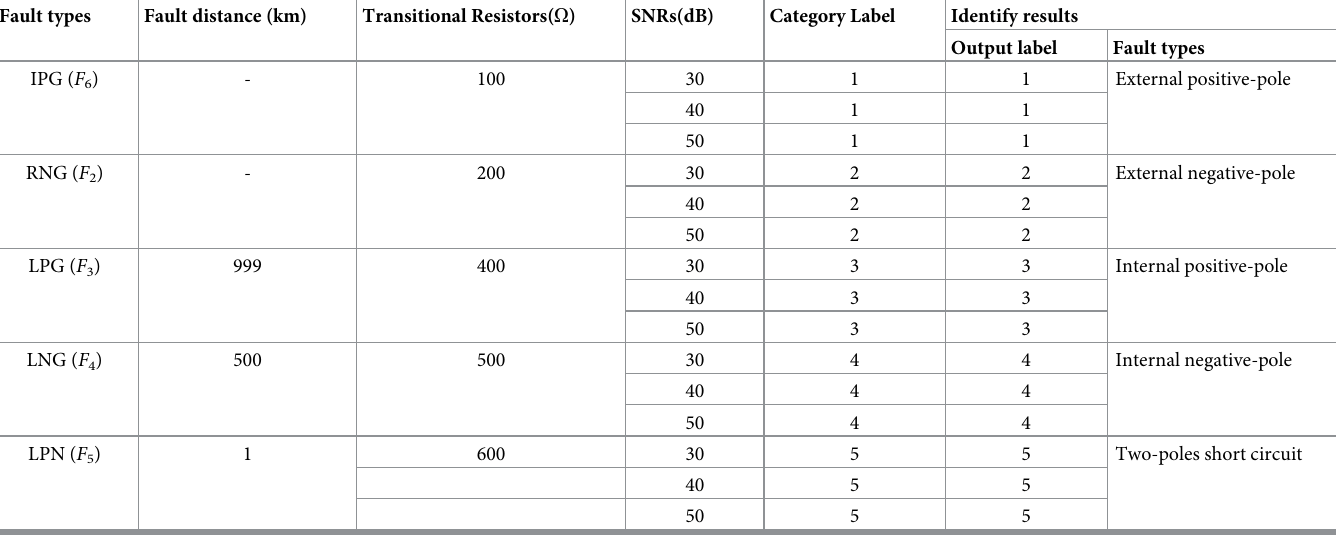
Table 9. Protection algorithm performance test considering noise